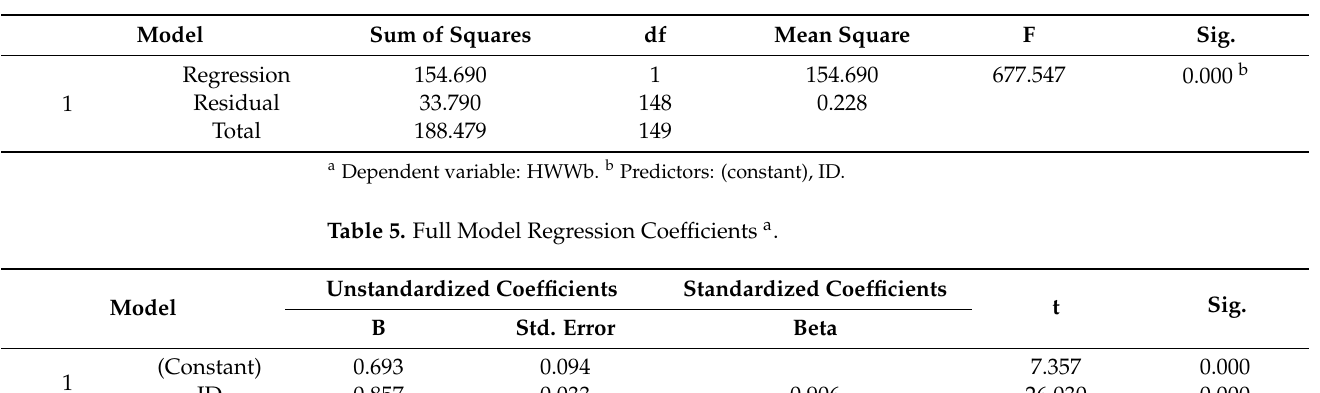
Table 4. ANOVA a .